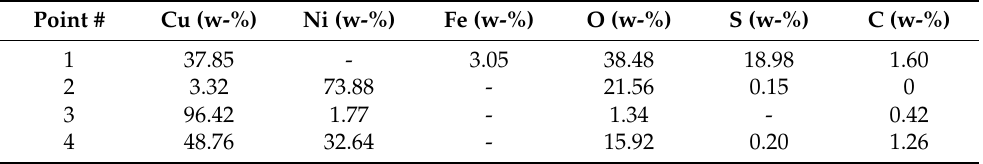
Table 7. EDS results from the analysis points shown in Figure 7b. No carbon was used in the experiment, but the traces detected by the EDS are from the chamber atmosphere as carbon is commonly sputtered on poorly conductive